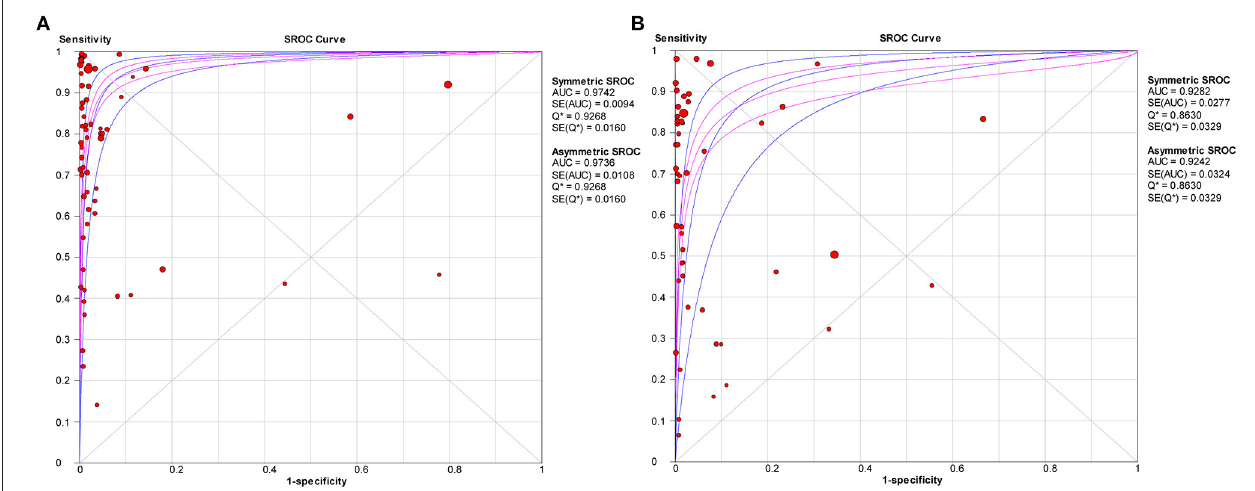
FIGURE 3 | SROC curve with pooled estimates of sensitivity, specificity, and the AUC for all included studies IgG (A) and IgM (B) for predicting COVID-19 diagnosis. AUC, area under the SROC curve; SROC, summary receiver operator